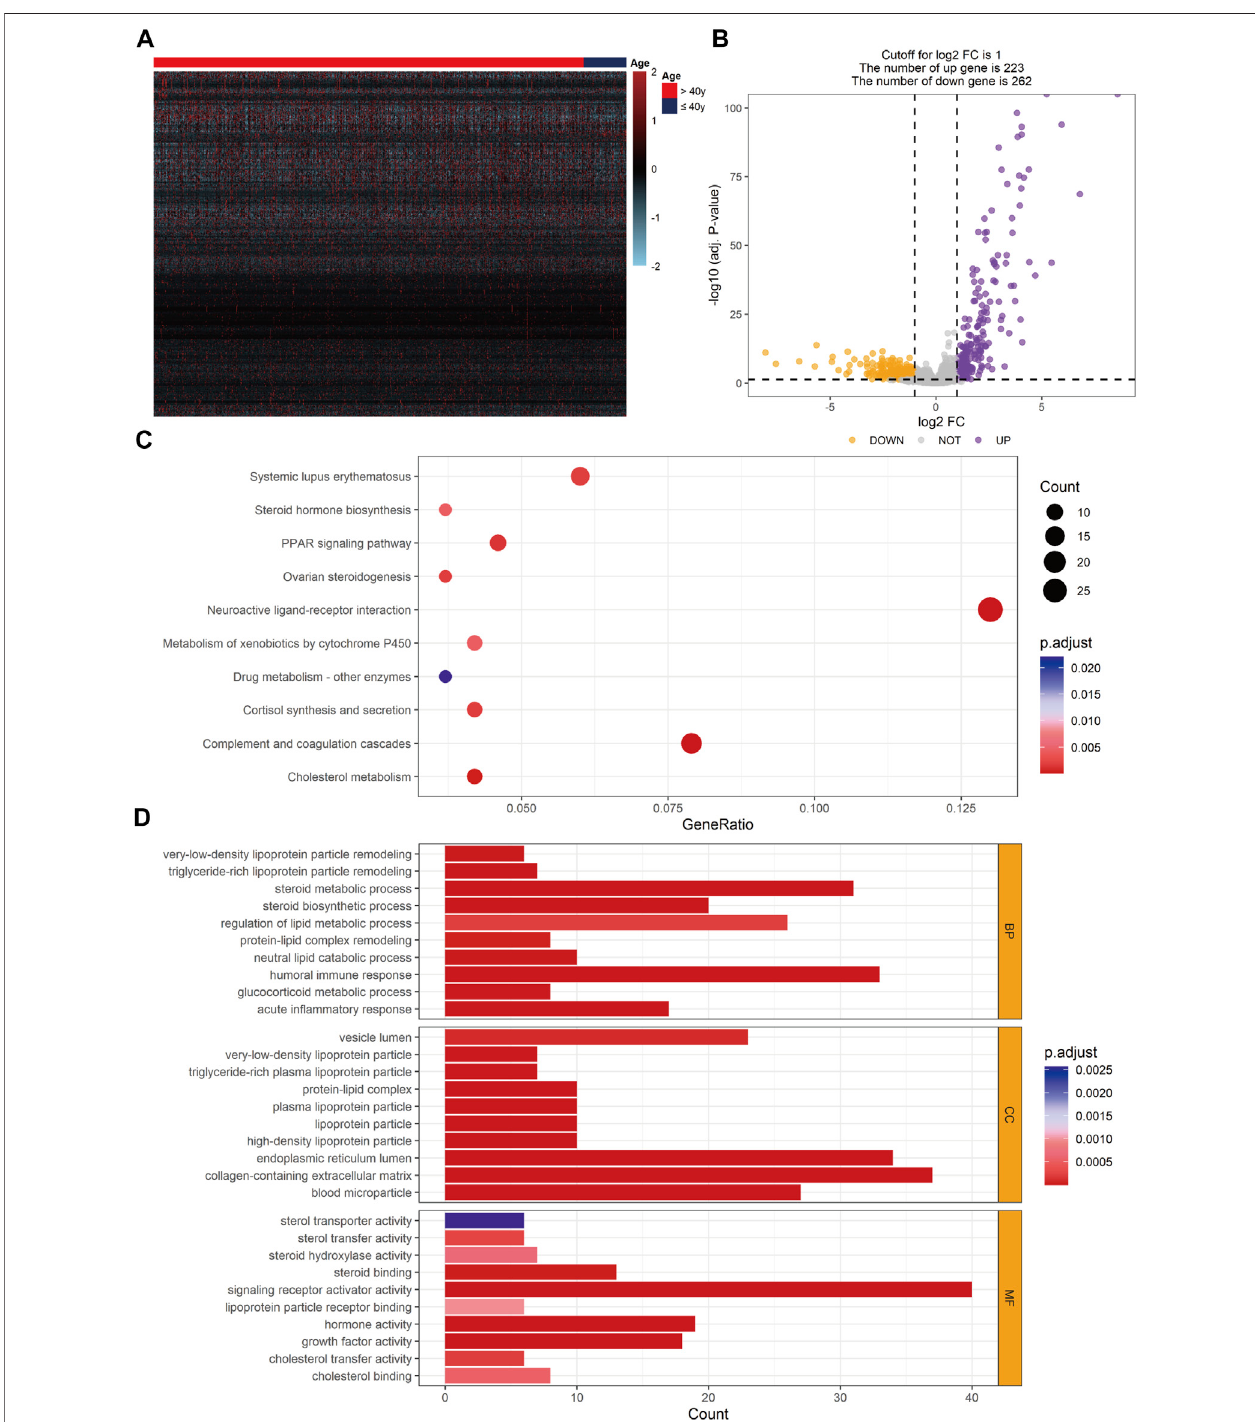
FIGURE 7 | Identi fi cation of DEGs and enriched function pathways between young and non-young cohorts. (A) Heatmap of DEGs in TCGA-BRCA database. (B) Volcano plot exhibiting 485 DEGs. (C) KEGG analysis result based on DEGs. (D) GO analysis result based on DEGs. DEG, differentially expressed gene.